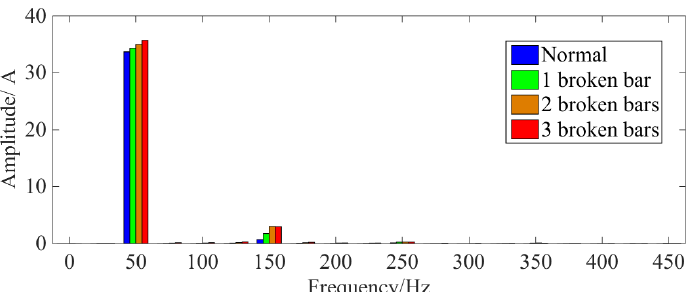
Figure 8. FFT results of stator current signal under rated load.